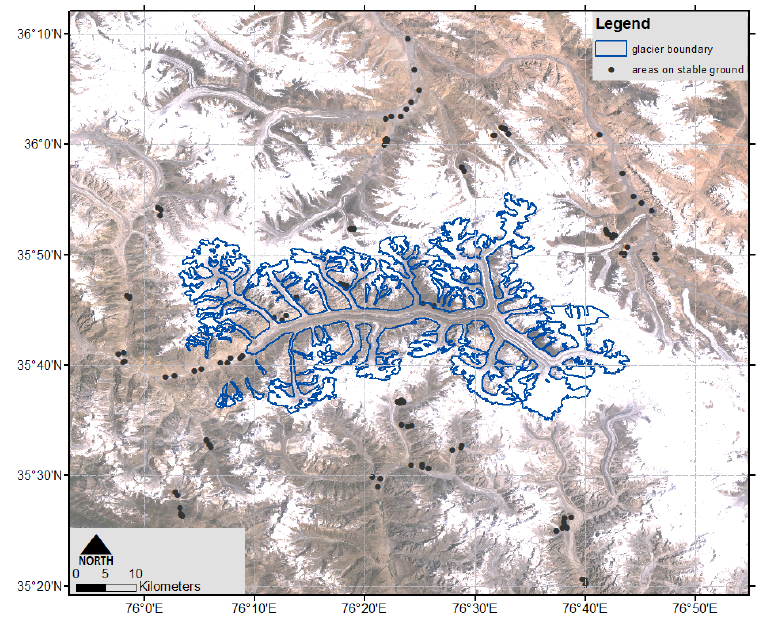
Figure A1. Overview of the Baltoro Glacier, Pakistan, with the 121 areas on stable, non-moving, and non-glaciated ground that were used for the uncertainty analysis of the surface velocities. The background image is a Landsat-7 scene acquired on 12 July 2010, which is also used for the digitalization of the glacier